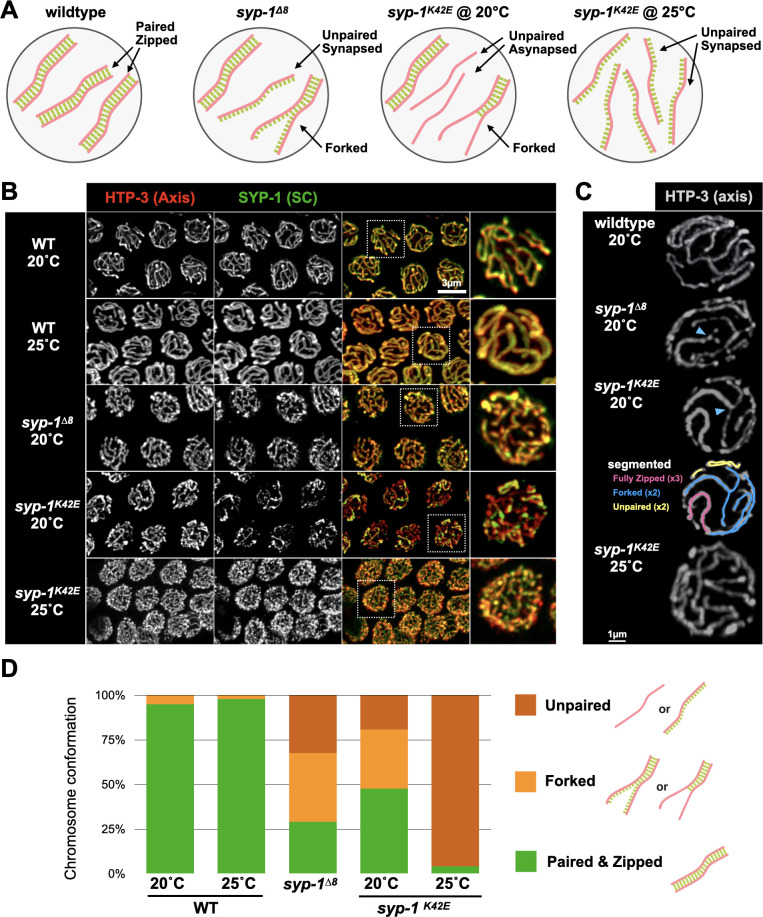
syp-1 mutants display distinct defects in SC assembly.A) Model of chromosomal organization and SC association in syp-1 mutants. For simplicity, only three homolog pairs are shown. Salmon, chromosome axis; green, SC; gray; nuclear envelope. B) Pachytene nuclei from wild-type worms and syp-1 mutants showing synapsis defects. Nuclei are labeled with antibodies against the axis protein HTP-3 (red) and the SC (anti-SYP-1 antibodies; green). Higher magnification images are shown to the right. Notably, the SC fails to fully associate with all chromosomes in syp-1K42E at 20°C, as revealed by axis signal not associated with SC. Note the numerous SC threads in syp-1Δ8 and syp-1K42E (25°C), caused by the unpaired chromosomes still associated with the SC. Scale bar = 3μm. C) Partial projections of detergent-extracted pachytene nuclei from wild type and syp-1 mutants labeled with anti-HTP-3 (gray). The enhanced resolution allows tracing of the different synapsis outcomes, shown for syp-1K42E (20°C; skeletonized segments): fully zipped (pink), forked (blue), and unpaired and asynapsed (yellow). Forked chromosomes are indicated with a blue arrowhead. Scale bar = 1μm. D) Summary of the different chromosomal conformation in pachytene nuclei from wild-type and syp-1 mutant worms. Only chromosomes that were clearly laid out on the xy-plane of partially projected gonads were scored. The density of unpaired chromosomes in syp-1K42E (25°C) animals made them difficult to count; therefore, only zipped chromosomes were counted and all other chromosomes were assumed to be unpaired. N>95 chromosomes from at least 3 different gonads in each condition. All pairwise comparisons to wild type are significant (Pearson’s chi-squared test, where ‘unpaired’ and ‘forked’ configurations were grouped together; p<0.0001).